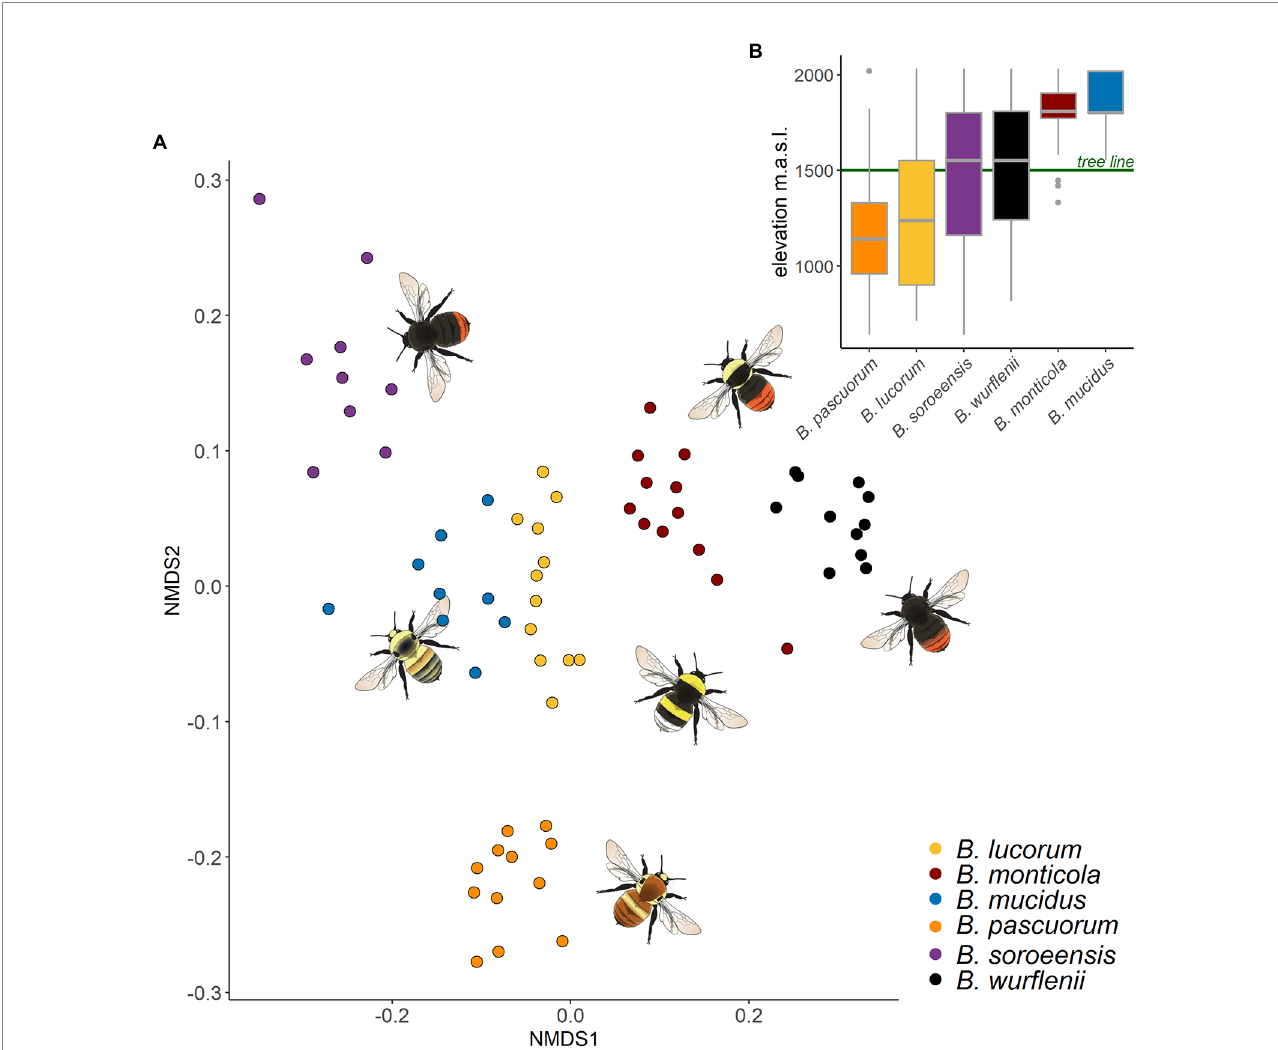
FIGURE 3 Similarity of the CHC profiles of six bumble bee species and distribution of these species along the elevational gradient. (A) Similarity of CHC profiles of bumble bees displayed in a two-dimensional graph by non-metric multidimensional scaling (NMDS) based on Bray-Curtis distances. Dots represent CHC profiles of individuals, dot colors the respective species. The closer the dots, the more similar the CHC profile. (B) Bumble bee distribution along the elevational gradient recorded within an intensive monitoring conducted between June and September 2019 (see Supplementary material S1). The green line refers to the tree line in the study region. CHC profiles are clearly determined by species however, species profile similarity does not reflect similarity in the elevational